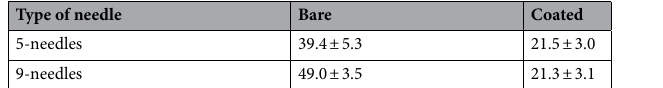
Table 1. Average full width at half maximum (FWHM) pixel values of line-scan gray-level intensity profiles obtained from tattoos created by bare and coated 5- and 9-needles in the image of Fig. 3. Note that at least three measurements were performed on each tattoo created by the needle. Each set of bare and coated 5- and 9-needles created 10 tattoos at various locations on the pork skin. 1 pixel is equal to ~ 25.6 µm.